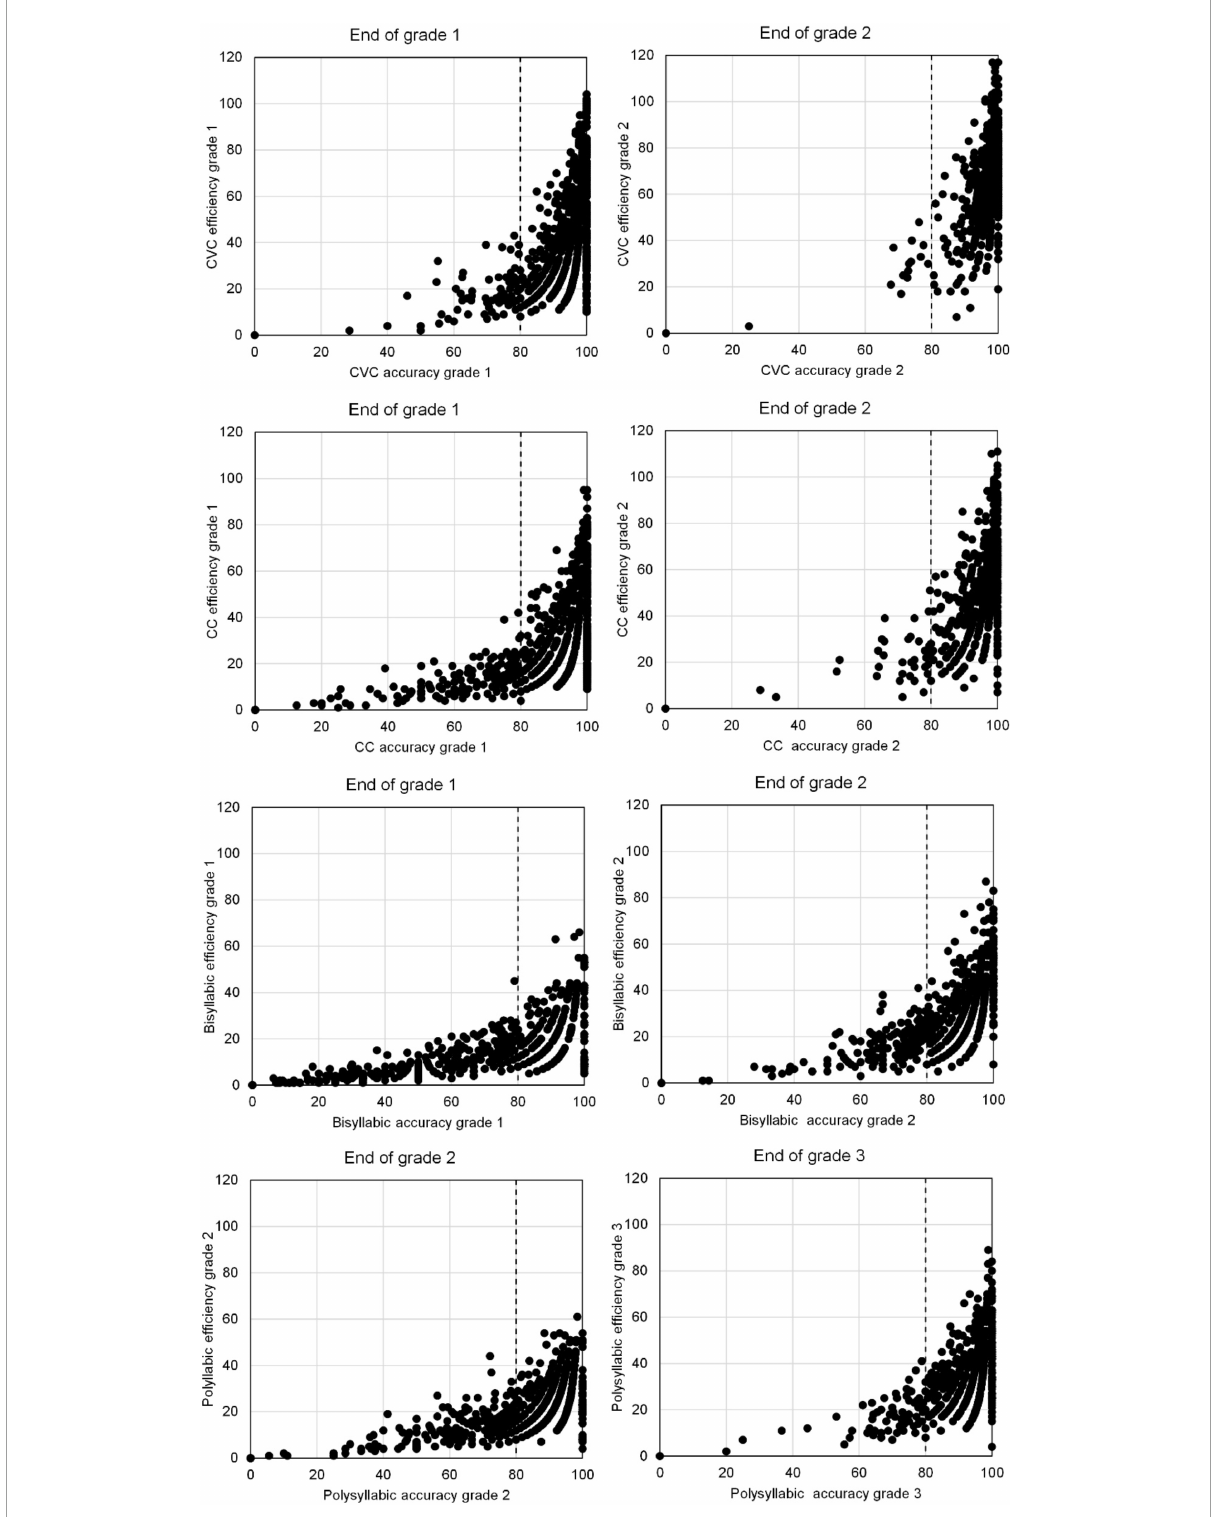
FIGURE1 Scatterplots of accuracy (percentage correct) and efficiency (number of words correct in 1 min) of word decoding at the end of Grade 1 and Grade 2, for CVC, CC, and bisyllabic words. Also scatterplot of accuracy and efficiency of reading polysyllabic words at the end of Grades 2 and